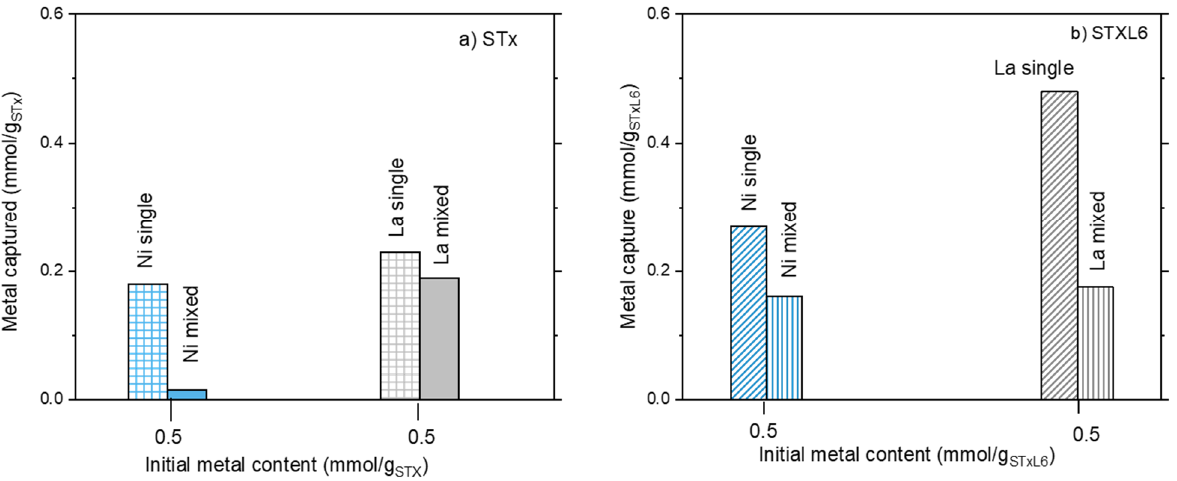
Figure 2. The ratio between metal capture and contacted metal at the same initial ion concentration in single and mixed metal ions solutions: ( a ) unmodified STx and ( b ) modified STXL6.